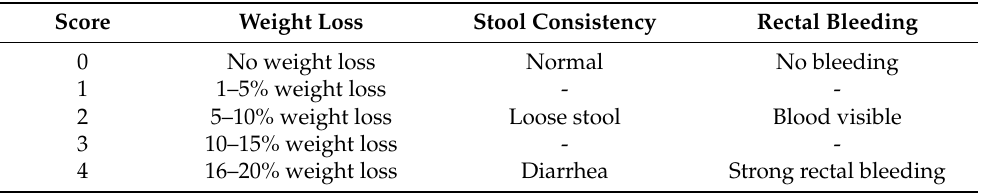
Table 1. Score parameters for the assessment of colitis. Sum of scores represents the disease activity index (DAI).